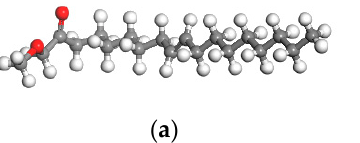
Figure 1. Bio-oil model: ( a ) C 18 H 32 O 2 and ( b ) C 18 H 34 O 2 .